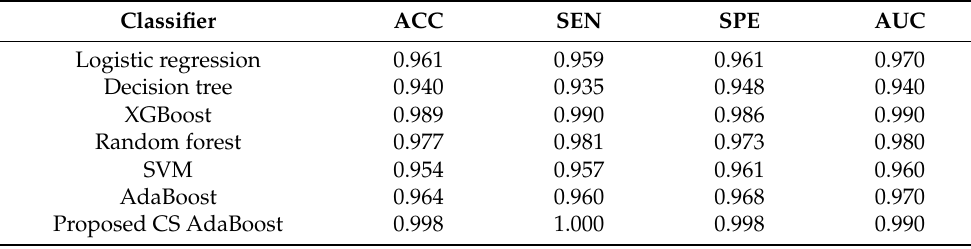
Table 4. Performance of the classifiers trained with the reduced feature